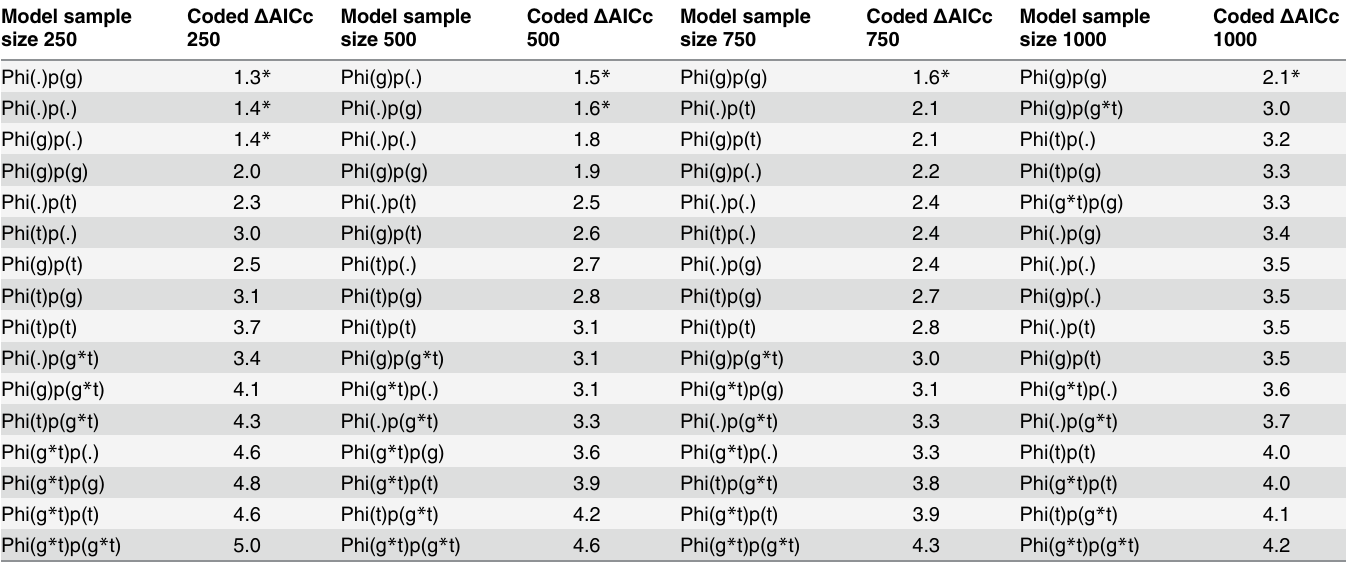
Table 2. Comparison of model performance with increasing sample size.